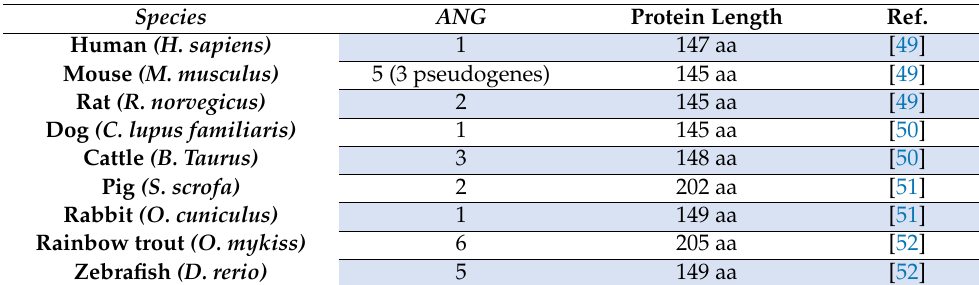
Table 2. ANG and pseudogenes discovered in mammals and higher